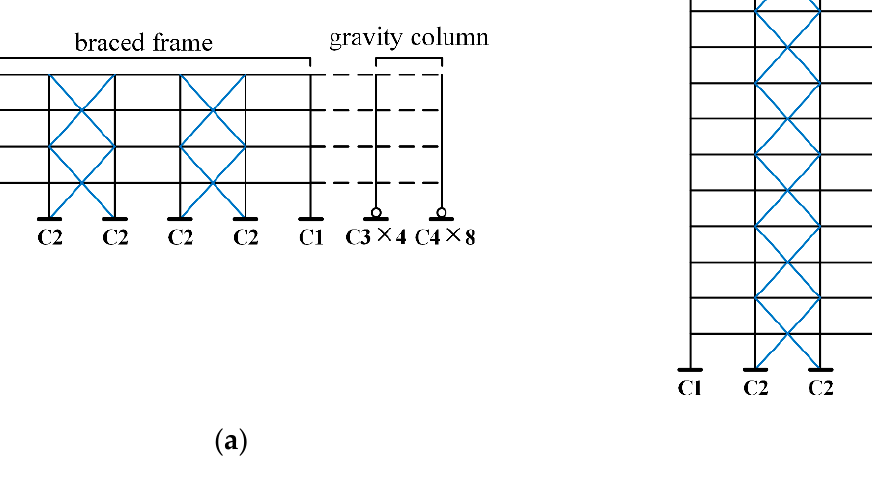
Figure 11. 2D model: ( a ) 4-story structure and ( b ) 12-story structure. According to the Code for Seismic Design of Buildings in China (GB 50011-2010) [47], the lower limit of the 4-story and 12-story PCF-BRB structure stiffness ratio should be 1.5 and 3, respectively. It is specified that the seismic overturning moment (distributed by the stiffness) of the bottom braced frame should be greater than 50% of the total seismic overturning moment of the structure. Therefore, the k values of 4-story PCF-BRB were selected as 1.5, 2, 3, 4, 5, 6, and 7, and those of 12-story PCF-BRB were 3, 4, 5, 6, and 7. The yield section area of BRBs with each stiffness ratio is listed in Table 8, and the overall information of the PCF-BRB structure is listed in Table 9. The yield and ultimate displacement of BRBs were 3.94 and 94 mm, respectively. The input yield and ultimate forces of BRBs are shown in Table 10 to define the bilinear relation. The hardening factor was 1.2, the maximum plastic and accumulated plastic deformations at full hardening as a ratio of yield were both 18.8 [40], and the proportion of accumulated plastic deformation was 0 [31]. Each structure model is named after modal A-B, among which A represents the number of stories, and B represents the stiffness ratio value. For example, modal4-1.5 represents the 4-story PCF-BRB structure with the k value of 1.5. The elastic inter-story drift means the inter-story drift under a frequently occurring earthquake, which is possible to occur with a 63% probability of exceedance (with a return period of 50 years), and the structure is in an elastic condition. The proportion of seismic overturning moment carried by braces corresponded to the clause in GB 50011-2010 mentioned